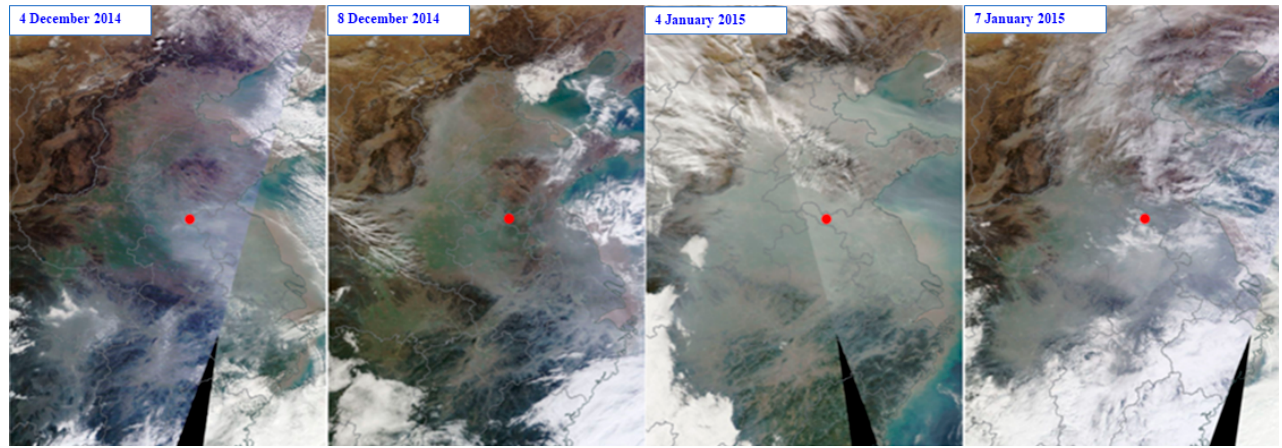
Figure 5. AQUA MODIS true-color images during lidar-observed aloft-haze-plume events (China Standard Time (CST)). On the four images, Xuzhou is indicated with a red dot (images sourced from: https://worldview.earthdata.nasa.gov/ (last access 3 February 2022).